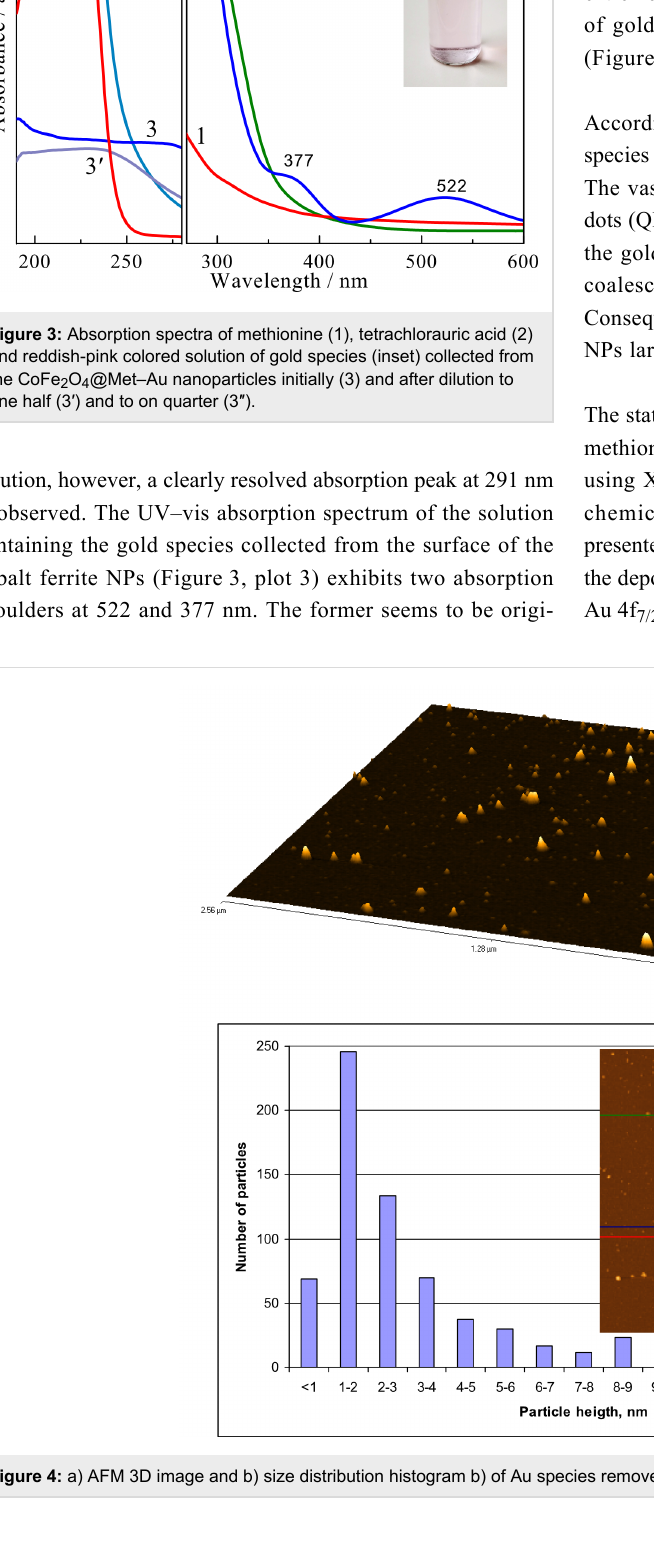
Figure 4: a) AFM 3D image and b) size distribution histogram b) of Au species removed from the surface of CoFe 2 O 4 @Met–Au NPs.